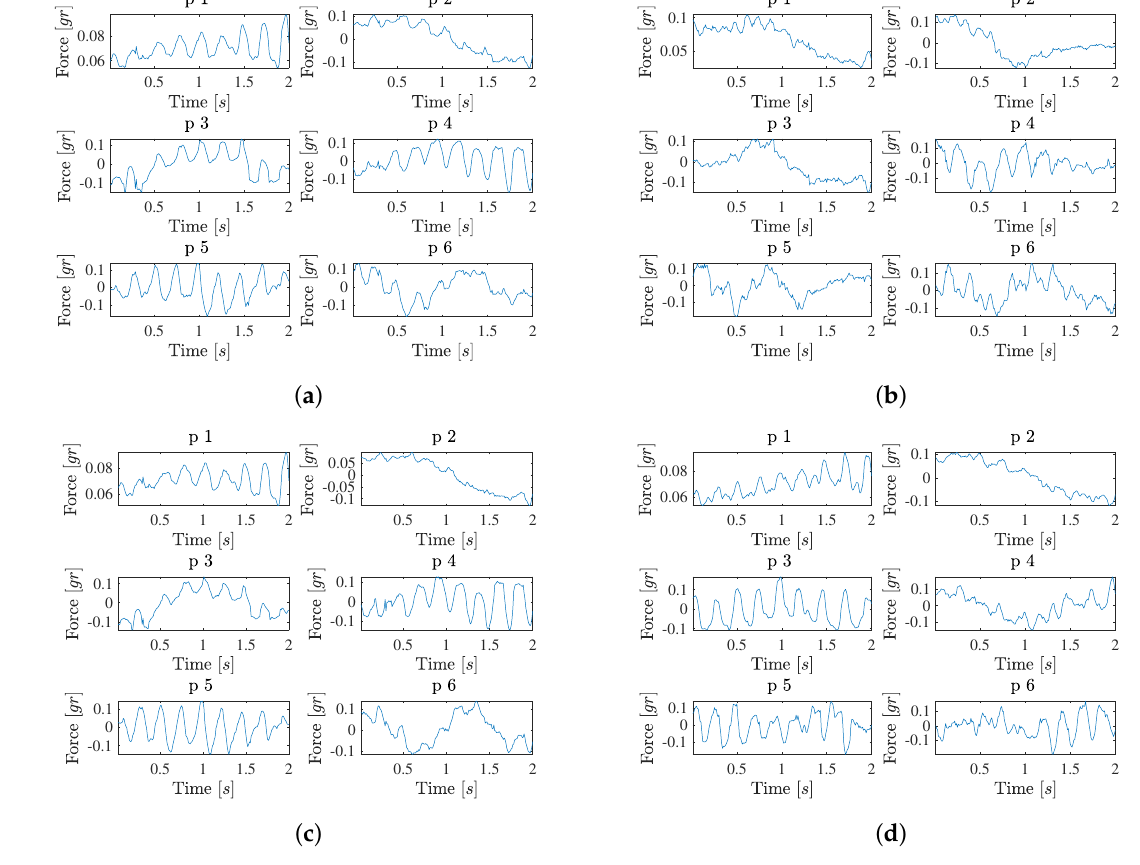
Figure 4. PCA results and signal patterns for the first 6 eigenvectors of the decomposition in likely contact ( a ), likely non-contact ( b ), likely ( c ), and high-confidence ( d ) groups, using all cases and both contact and non-contact groups,